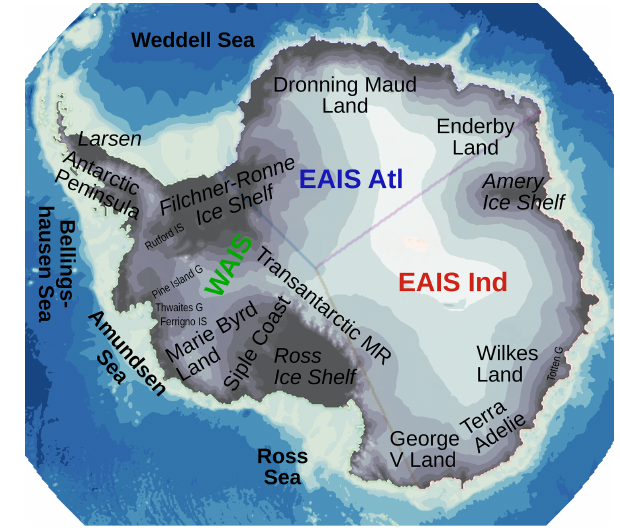
Figure 1. Map of Antarctica. The seafloor depth is shown using a blue color scale, and the elevation of Antarctica above sea level is depicted using a dark-gray (low elevation) to white (high eleva- tion) color bar. Ocean labels are displayed using bold font, and ice shelves are displayed using italic font. Labels with smaller font sizes show individual glaciers (G) and ice streams (IS). “MR” stands for “mountain range”. Colored labels define three regions: WAIS refers to the West Antarctic Ice Sheet (green), EAIS Atl refers to the East Antarctic Ice Sheet – Atlantic Sector (blue), and EAIS Ind refers to the East Antarctic Ice Sheet – Indian Ocean Sector (red). These regions are bound by the coastal areas and by their shared bound- aries in the interior. Figs. 4 and 5 also show the boundaries of these regions. The bedrock topography and surface orography depicted here are taken from Fretwell et al.